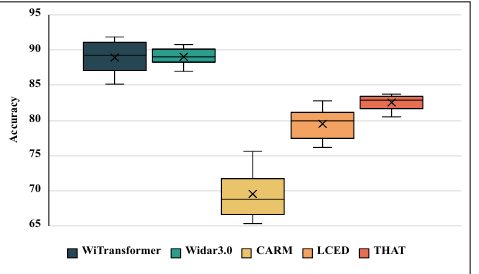
Figure 18. Recognition accuracies of the five methods on